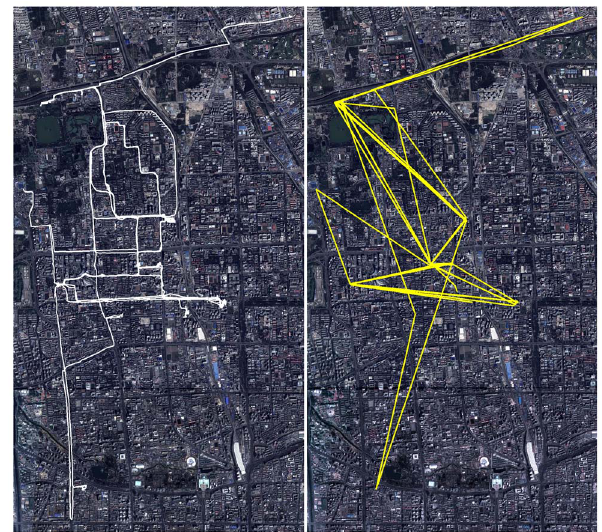
Figure 8. An example of the distinguishing of effective staying positions. The figure left shows original trajectory of one GPS carrier. The figure right shows the effective staying positions connected by lines in order, where each vertex represents an effective staying position.